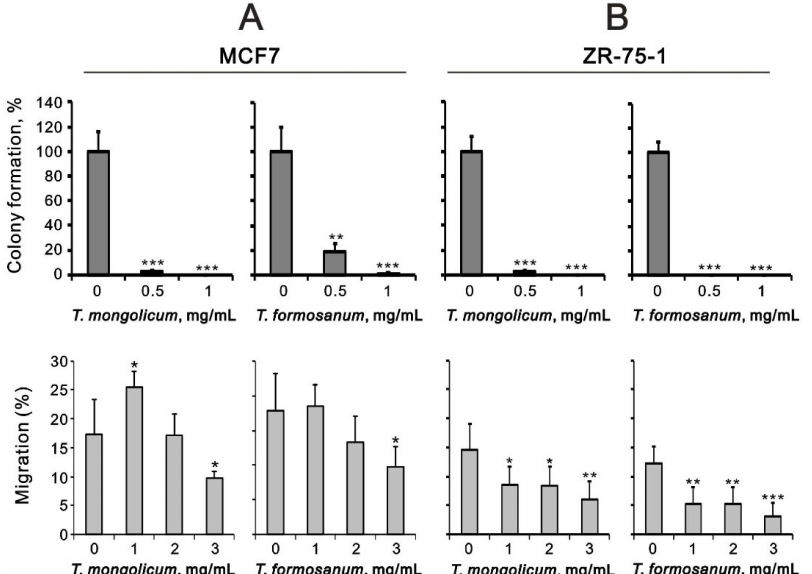
Figure 12. Effect of T. mongolicum and T. formosanum on colony formation by MCF-7 and ZR-75-1 cells. ( A ) MCF-7 and ( B ) ZR-75-1 cells were treated with the indicated concentrations of T. mongolicum or T. formosanum . Colony formation ( top ) was measured after 14 days, and cell migration ( bottom ) was measured after 24 h. The results are representative of two independent experiments. Bars depict the mean ± SD. * p < 0.05, ** p < 0.01, *** p <